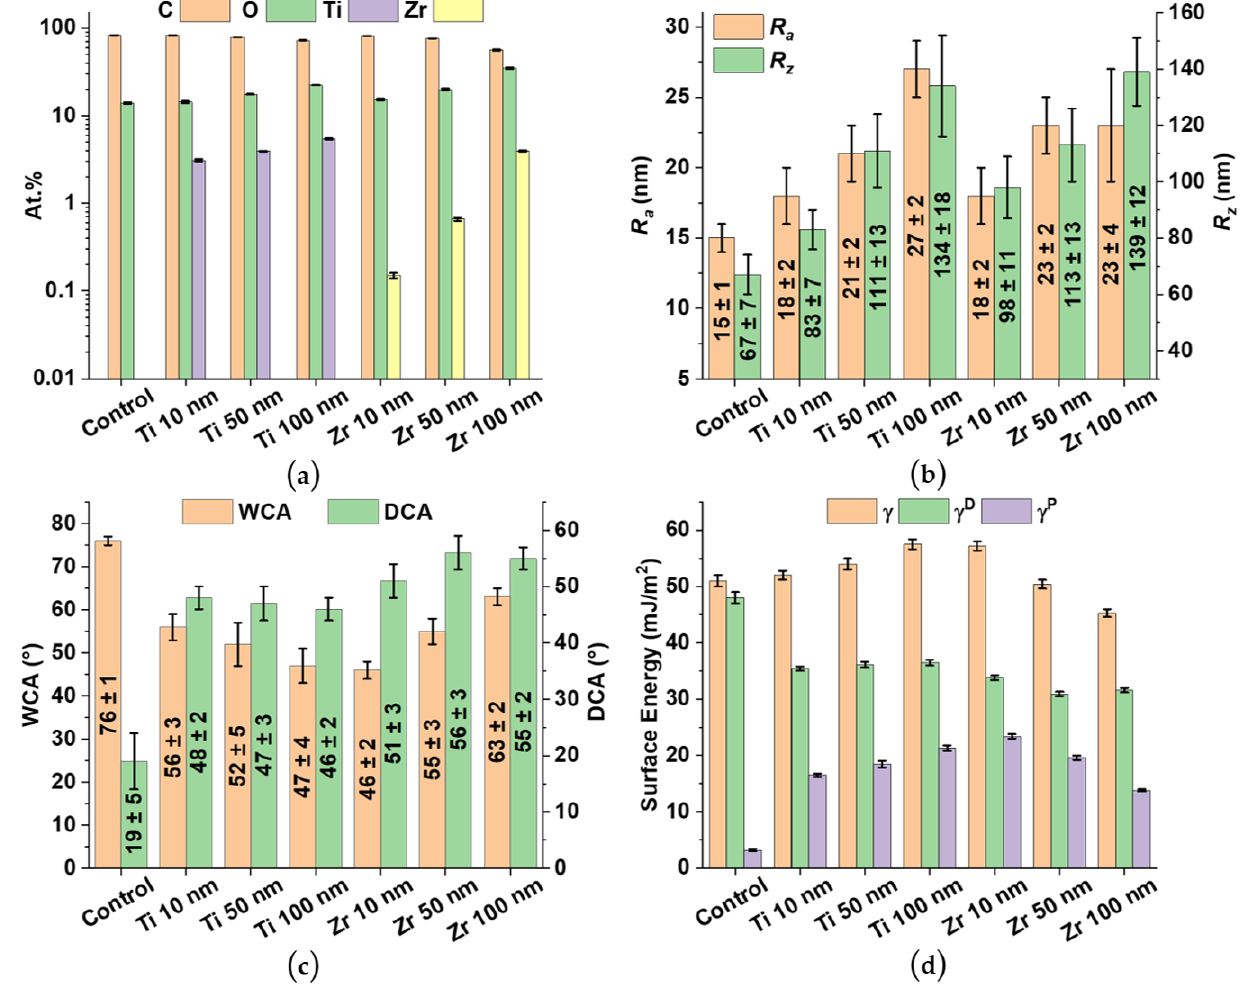
Figure 3. Chemical and surface properties of the investigated PEEK samples. Control is related to the unmodified PEEK samples, and Ti and Zr samples represent the ultra-thin film coated PEEK samples with coating thicknesses of 10 nm, 50 nm and 100 nm. ( a ) Elemental composition determined by EDX shown in at.% on a logarithmic scale for the y axis. ( b ) Surface roughness is given as R a (arithmetic mean roughness) and R z (average height difference) measured by AFM. ( c ) Surface wettability is presented as water contact angles (WCA) and diiodomethane contact angles (DCA). ( d ) The surface energy γ of the samples. Here, γ is also presented with the disperse component of the surface energy γ D and the polar component γ P .